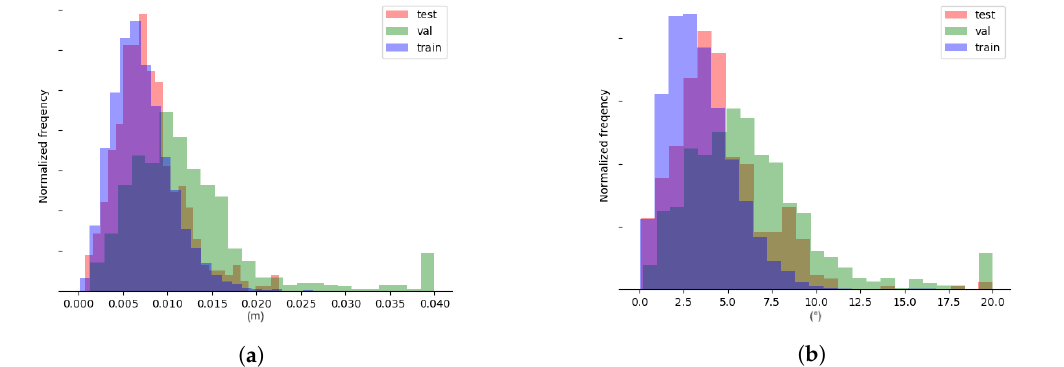
Figure 12. ( a ) Distribution of position errors. ( b ) Distribution of normal vector